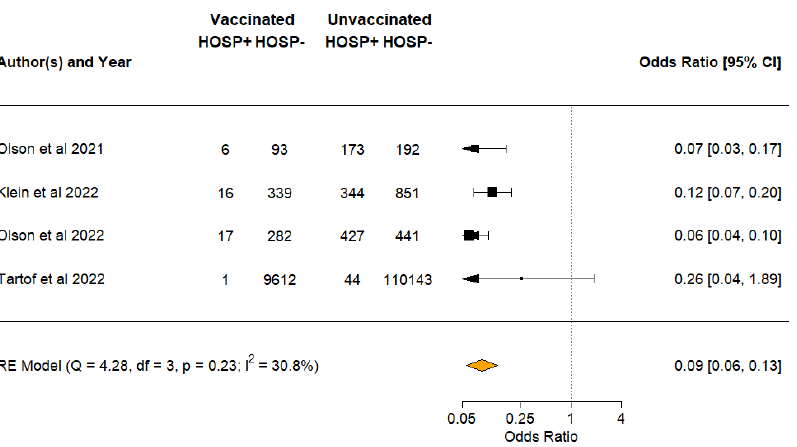
Figure 3. Vaccine effectiveness against hospital admissions [31,35–37]. The black square symbol presented for each study represents its point estimate, and the size is proportional to the weight of the study in relation to the pooled estimate. The red diamond symbol represents the overall effect estimate from the meta-analysis.